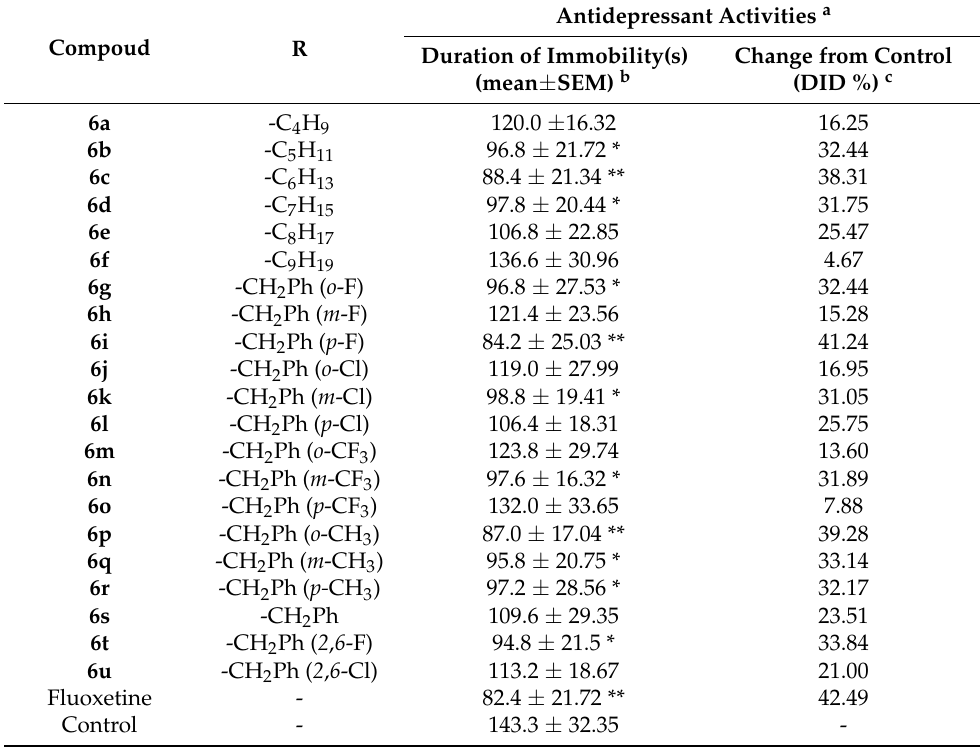
Table 1. Antidepressant activities of compounds 6a – u in FST.